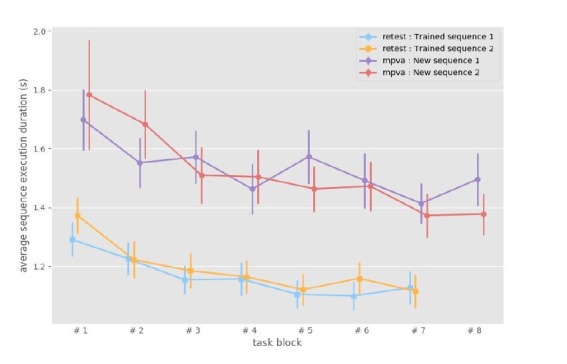
Sequence duration of Trained sequences in the first blocks for each sequence on the last experimental day (mean and standard error across participants).